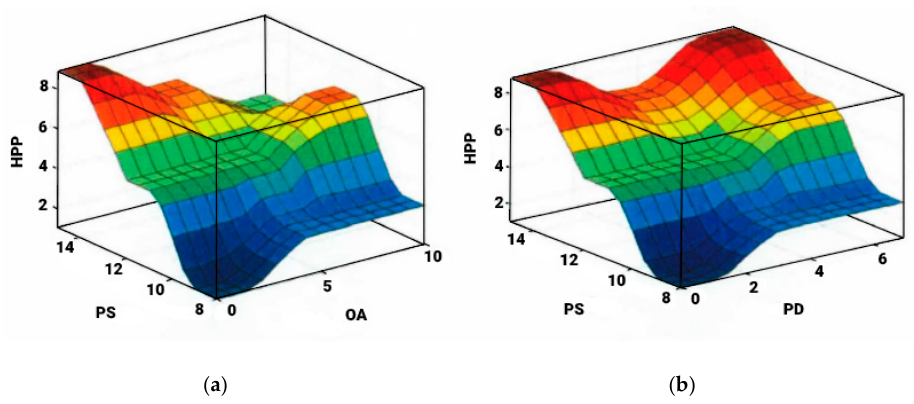
Figure 1. Fuzzy logic surface. ( a ) Fuzzy regular surface PS, OA-HPP. ( b ) Fuzzy regular surface PS, PD-HPP.